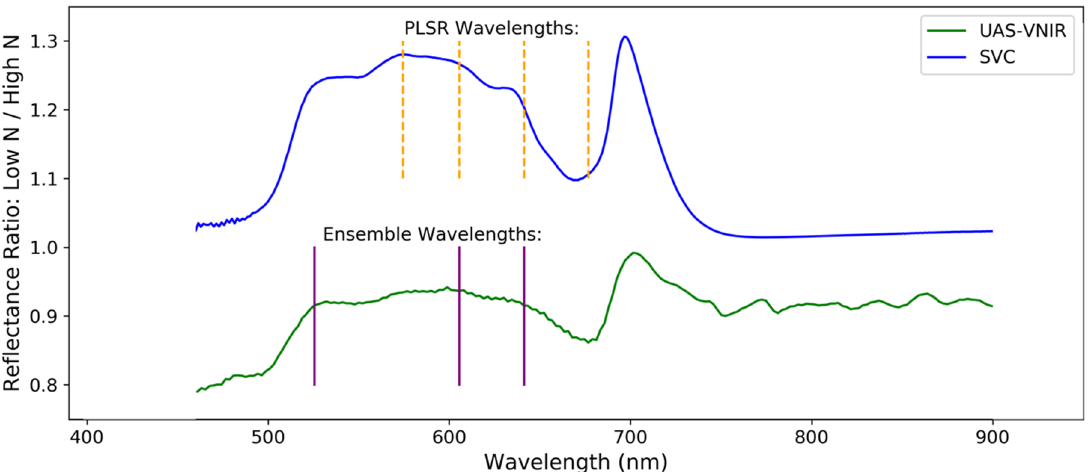
Figure 5. Ratio of the mean spectra from the 10-lowest and 10-highest N-content grapevines. The green ratio spectrum is from the UAS imagery, and the blue (upper) is from the SVC handheld leaf clip spectra obtained from two sample leaves per vine. The vertical lines mark the locations of wavelengths selected from the UAS data for the ensemble (purple solid) and PLSR (orange dashed) methods.